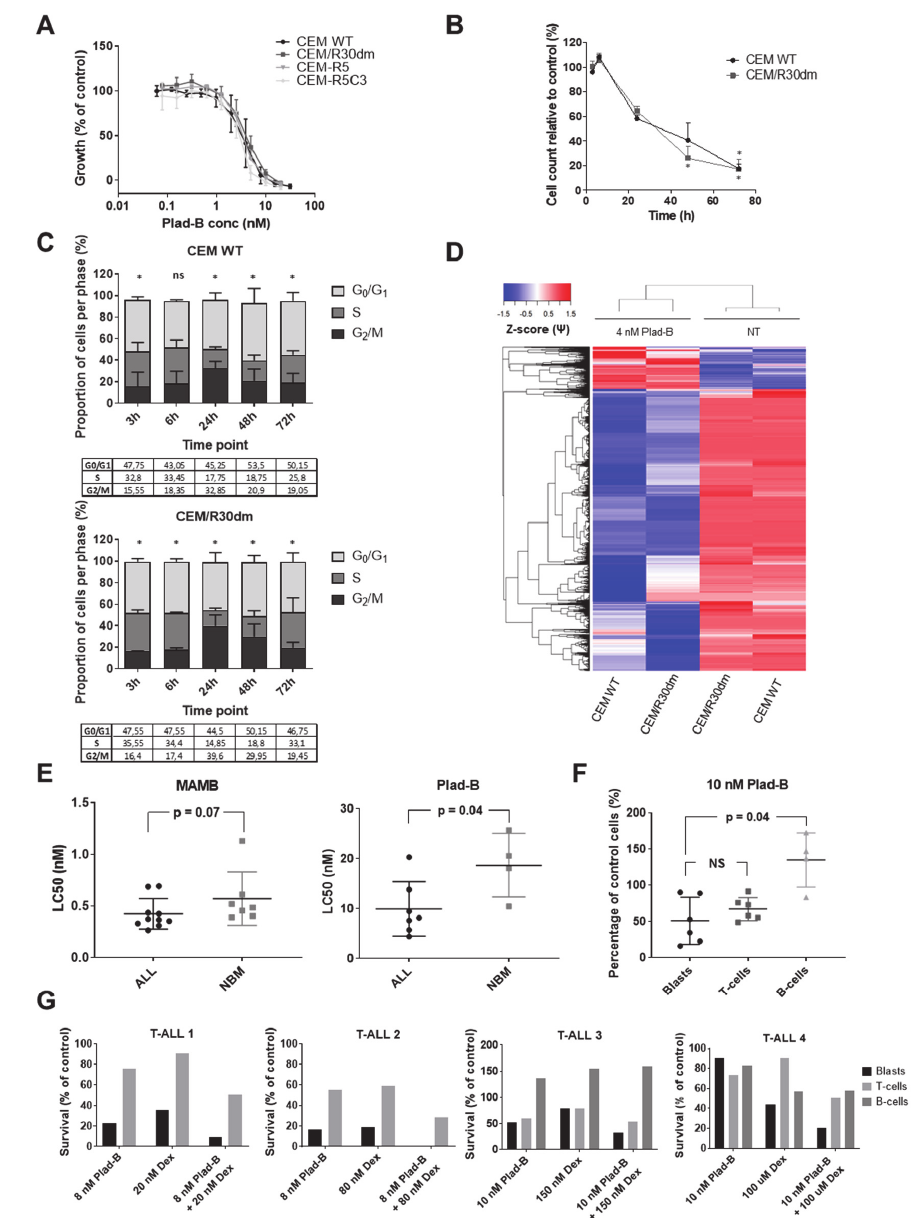
Figure 5. Response of (GC-resistant) T-cell ALL cells to splicing modulation. The figure illustrates the effects of splicing modulation on T-ALL cell lines and primary childhood samples as well as non-malignant specimens. ( A ) Response to Plad-B of GC-sensitive CCRF-CEM-WT cells as well as its GC- resistant sublines: CEM-R30dm, CEM-R5 and CEM-R5C3 in a 72 h MTT assay. The plot depicts the mean ± SD of at least 3 independent experiments. (B,C) Time-dependent inhibition of proliferation ( B ) and cell cycle arrest ( C ) induced by treatment with 4 nM Plad-B in CEM-WT and CEM-R30dm. The panel depicts the mean ± SD of 2 independent experiments. T-test was used for (B); asterisks in (B,C) indicate statistical significance ( p < 0.05); in (B), statistical significance for CEM-WT is indicated above the plotted line and for CEM-R30dm below the plotted line. Chi-square test was used for (C).